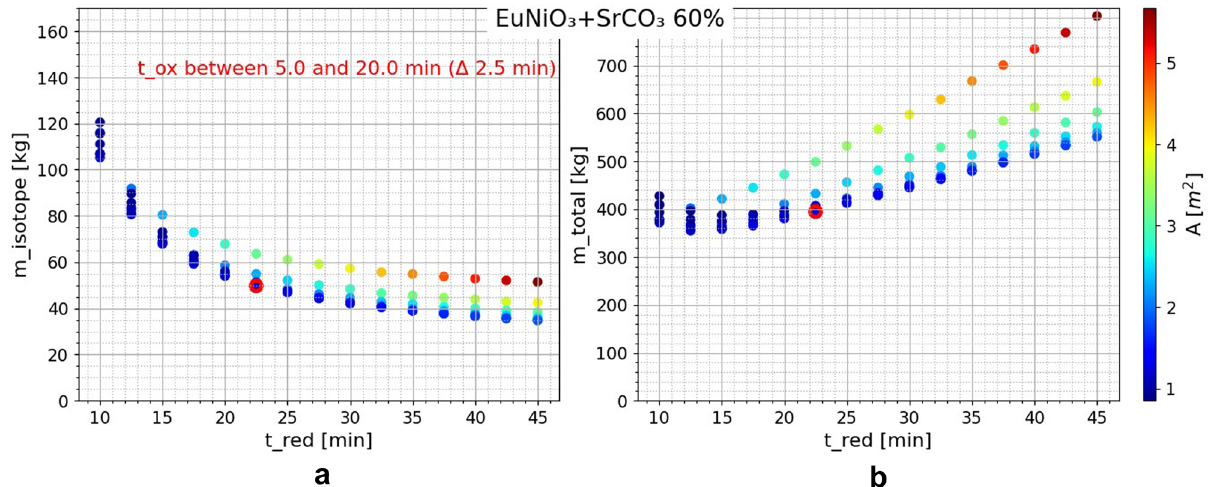
Figure 7. EuNiO 3 -SrCO 3 (60% 90 Sr) calculation results for ( a ) isotope mass m RI , ( b ) total curtain mass m total , (color) reactor chamber cross-sectional area A over t ox (projected axis) and t red (x-axis) variation; T ox = 300 ◦ C , T red = 425 ◦ C